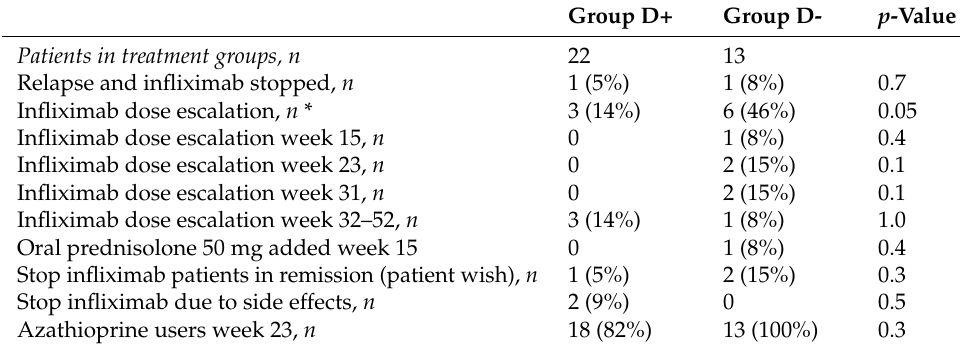
Table 1. Patients were followed until week 52 or if they stopped infliximab treatment. Differences in groups are tested with Fisher’s exact test. * Shortened infliximab interval was defined as treatment intervals shortened from week 8 to weeks 7, 6 or 4 due to increased disease